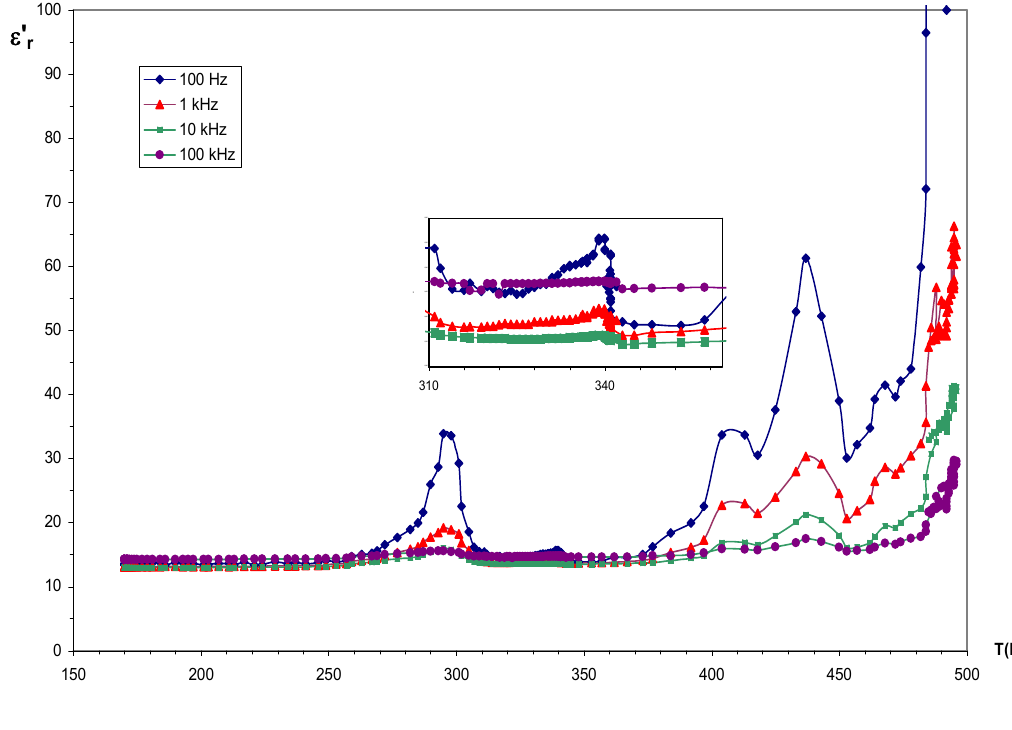
for compound 3 r